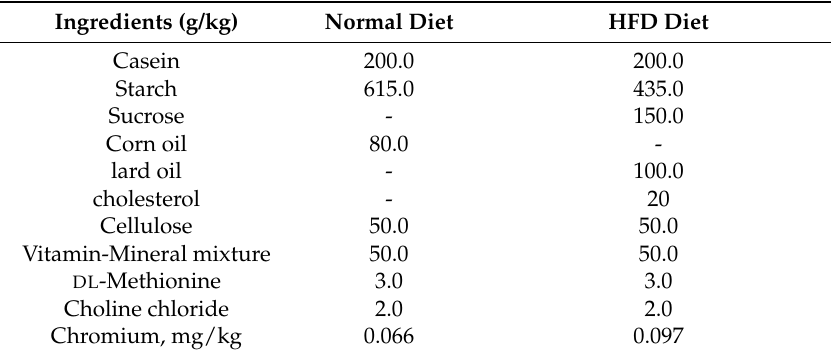
Table 1. Ingredient and nutrient composition of the diets